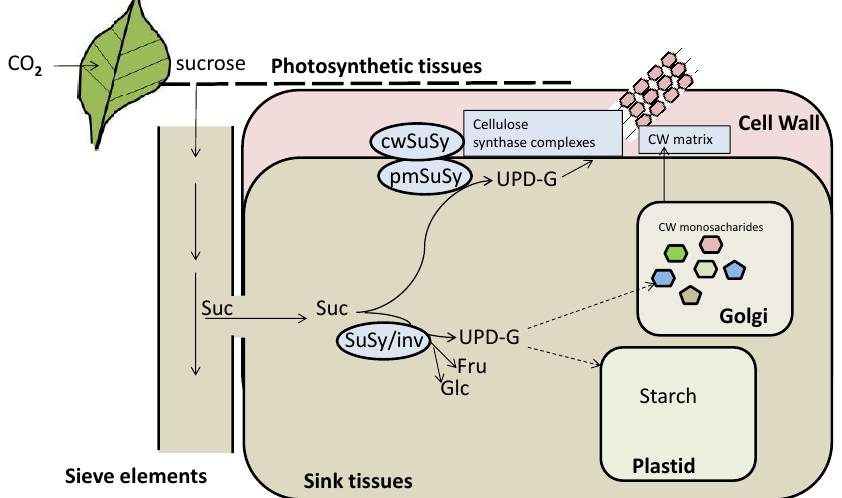
Figure 2. Photosynthesis is the source of carbon for CW synthesis. Fixed CO 2 in leaves by photosynthesis in the chloroplasts is transported through the phloem and unloaded into the cytosol as triose phosphates. In growing sink organs such as meristems, leaves, roots, tubers, and seeds, most of the primary CW synthesis takes place using sucrose as the source of C and energy. Sucrose synthase (SuSy) and invertases are key enzymes controlling sugar precursors for CW synthesis [41 – 44]. Sucrose synthase catalyzes the reversible transformation of sucrose into fructose and UDP-Glc. Invertases catalyze the irreversible breakdown of sucrose into glucose and fructose. For a comprehensive view of starch synthesis see [45 – 48].